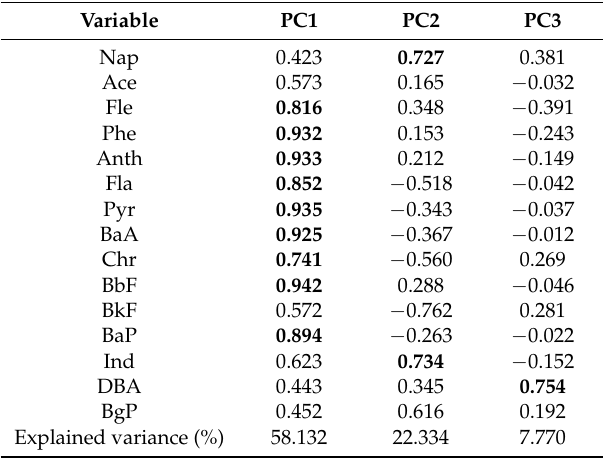
Rotated composition loading values of three principal components (PCs) for PAH compositional analysis.